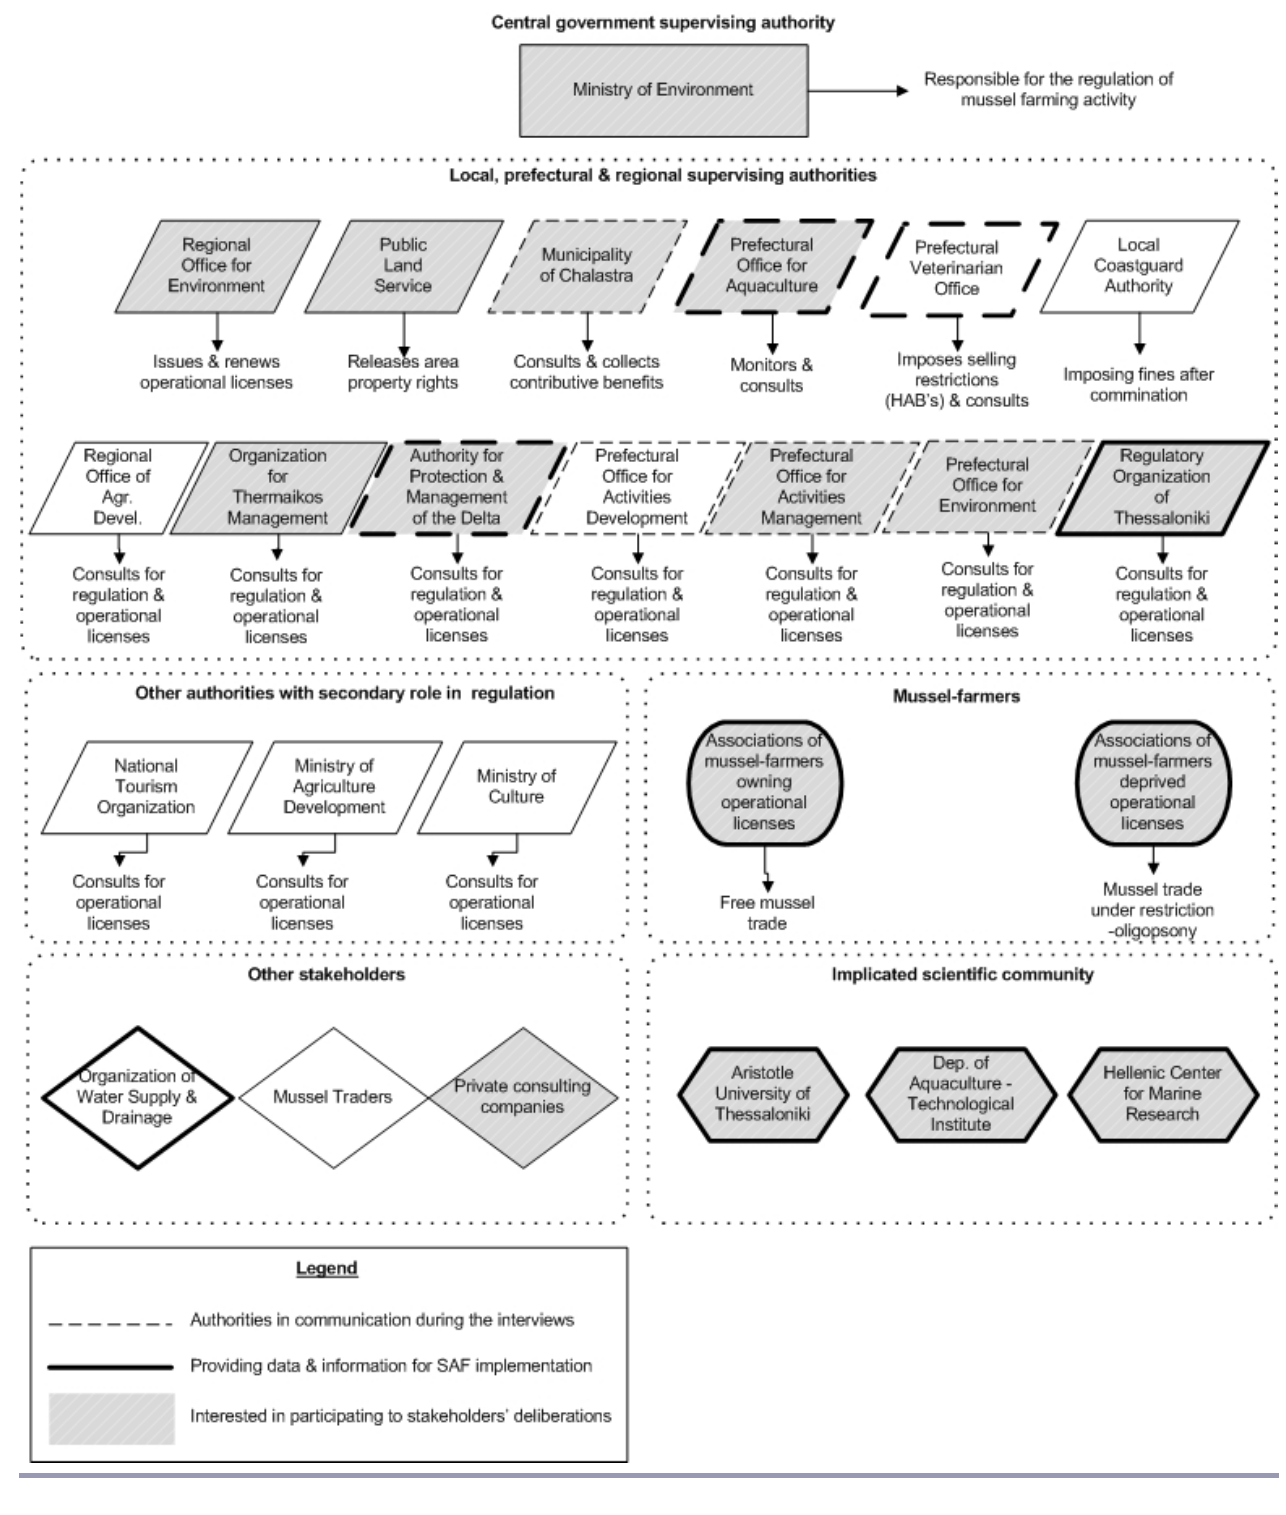
Fig. 6 . Map of institutional stakeholders for mussel-farming activity in